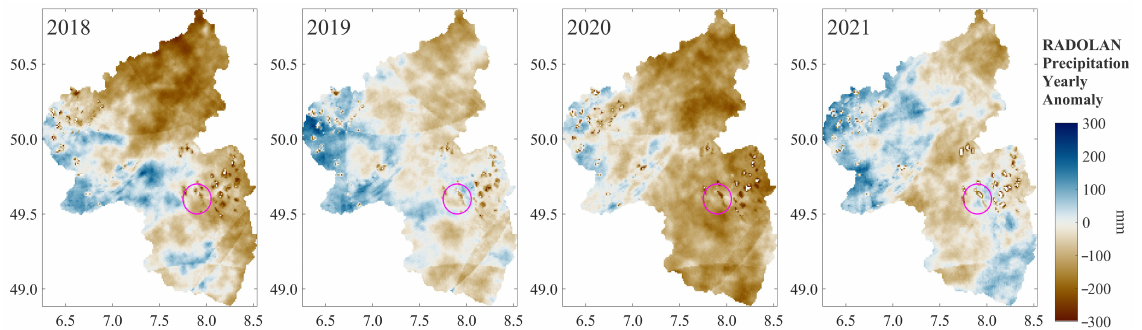
Figure 1. ( a ) Location of Donnersberg (orange) in Rhineland-Palatinate. ( b ) Area around the Donnersberg.